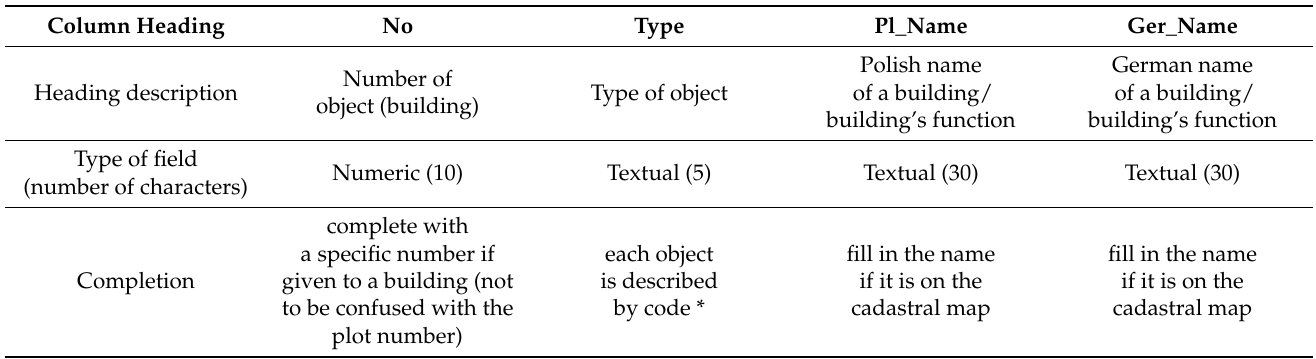
Table 2. An example of the structure and scope of information for the “build-up area” layer includ- ing coding.